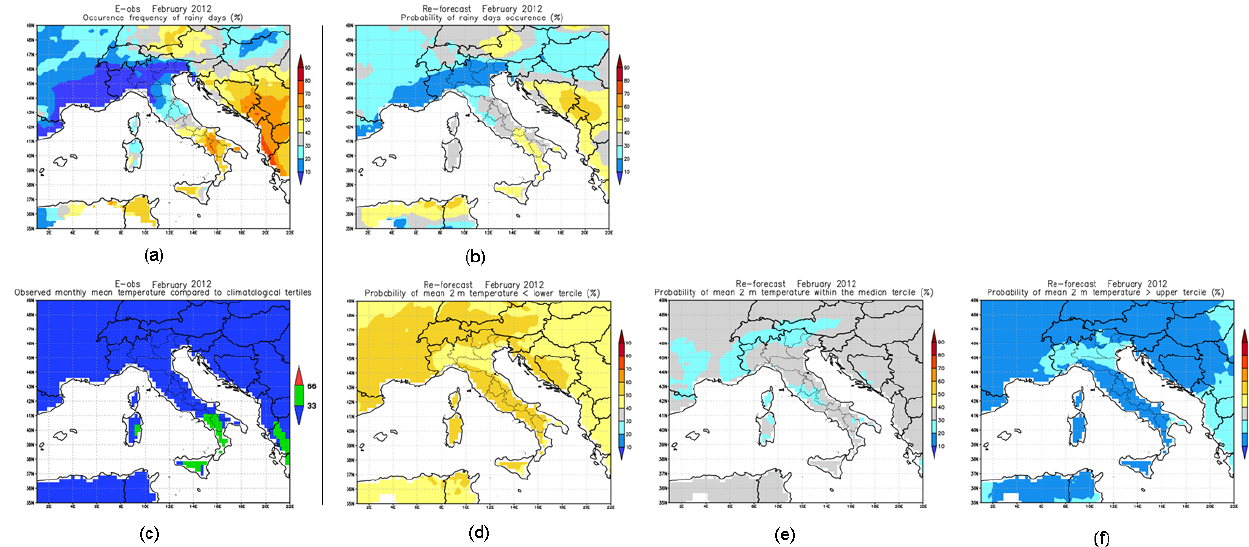
Figure 4. February 2012: observations E-OBS versus the operational chain re-forecast: the E-OBS occurrence frequency of rainy days (a) , the re-forecast probability of the rainy days occurrence (b) , the E-OBS tertile climatological distribution (c) , the re-forecast probability to stay below the lower tertile (d) , the re-forecast probability to stay within the median tertile (e) and the re-forecast probability to stay above the upper tertile (f) .